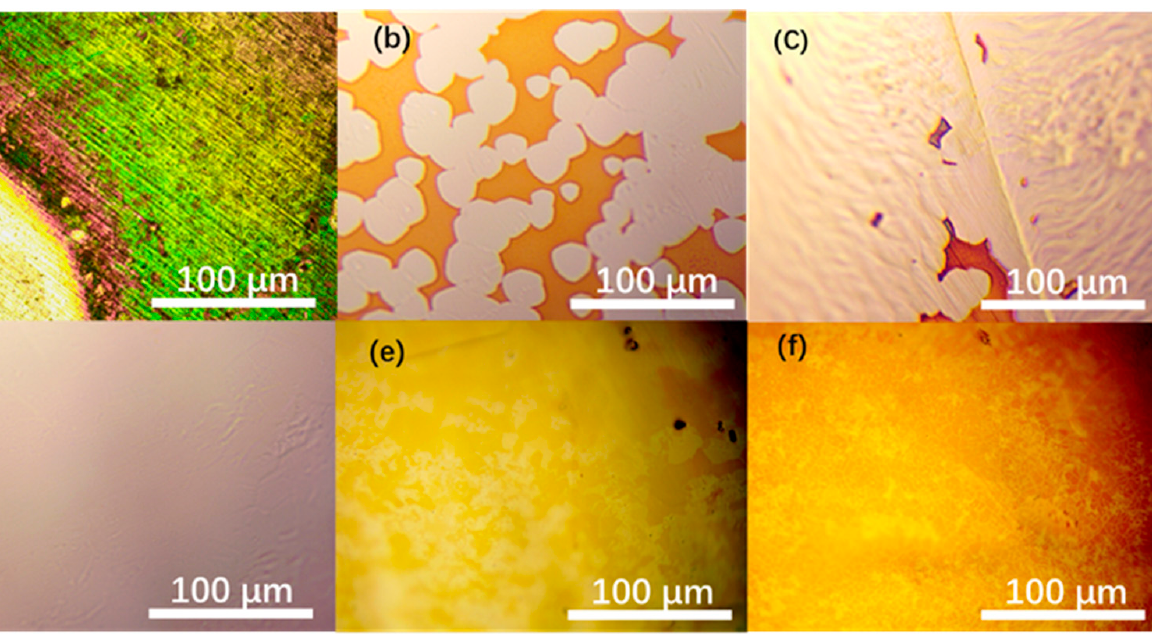
Figure 3. Growth states of h-BN on substrates with different reaction times. ( a ) 1 min, ( b ) 5 min, ( c ) 7 min, ( d ) 10 min, ( e ) 11 min, and ( f ) 15 min.